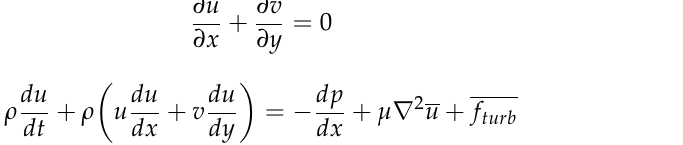
aged continuity equation for the conservation of mass (Equation (2)) and the Reynolds- averaged Navier-Stokes equation for the conservation of momentum (Equation (3)). The work. Equations (4) and (5) represent the k-epsilon turbulence model where, 𝑃 (cid:3038) is the turbulence production due to viscous forces (Equation (6)), 𝜇 (cid:3047) is the turbulence viscosity and C µ , C ε 1 , σ k , σ ε , and C ε 2 are constants. To model these conditions (i.e., confined (Equation (7)), and 𝐶 (cid:3091) , 𝐶 (cid:3084)(cid:2869) , 𝜎 (cid:3038) , 𝜎 (cid:3084) , and 𝐶 (cid:3084)(cid:2870) are constants. To model these conditions (i.e., confined and surface flow), the constants in the equation i.e., 𝐶 (cid:3091) , 𝐶 (cid:3084)(cid:2869) , and 𝐶 (cid:3084)(cid:2870) were ap- plied with values 0.0845, 1.42, and 1.68, respectively, which are widely used standard con- verged values.